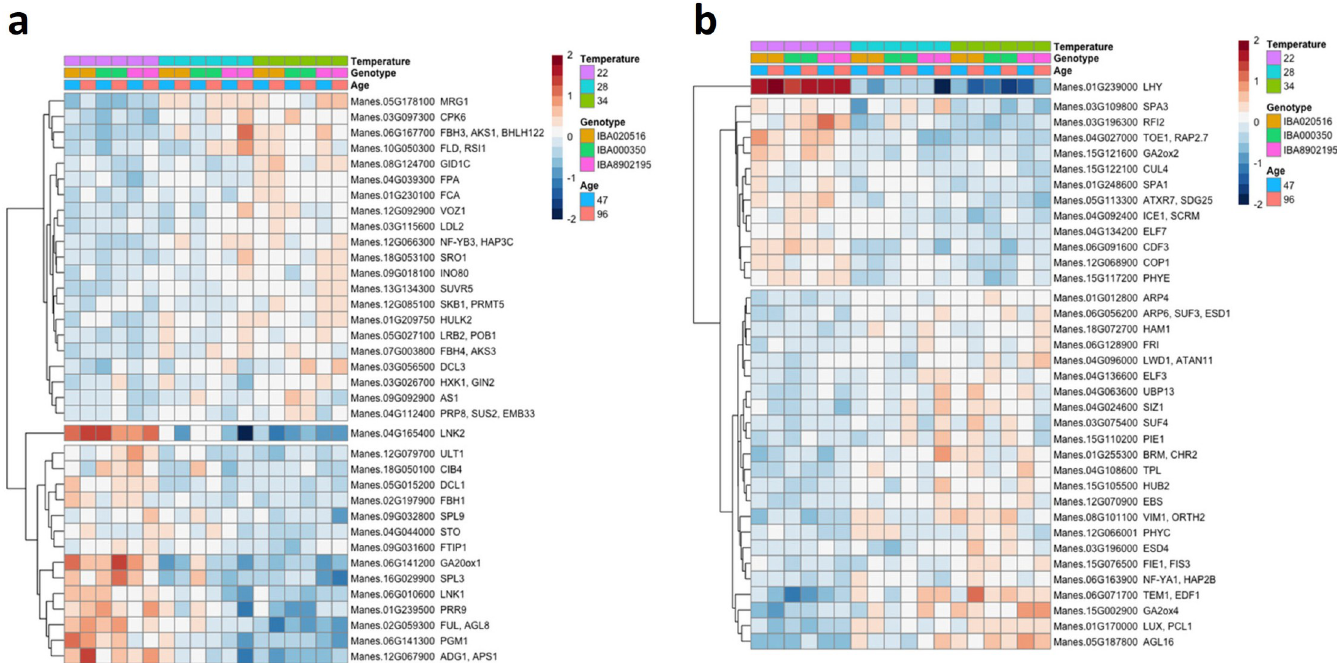
Fig 11. Relative expression (log 2 scale) of differentially expressed flowering-time genes in response to controlled-environment temperature (22, 28 or 34˚C), genotype (‘516, ‘350, ‘2195), and timepoint of development (47 and 96 DAP). a) genes which have a positive effect (hastening) on flowering time in Arabidopsis; b) genes which have a negative effect (delaying) on flowering time in Arabidopsis. Each gene is identified by its Manihot esculenta number (Manes) and its closest Arabidopsis homolog. Color scale indicates log 2 fold changes. Legend in header indicates color-coding of variables.